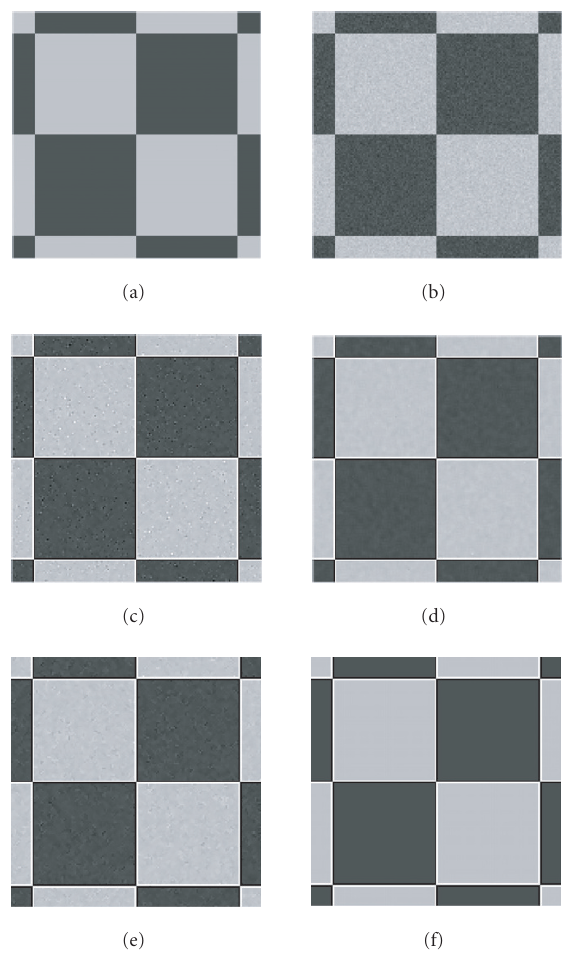
Figure 3: Details of (a) a synthetic image, (b) image corrupted by Gaussian noise with variance 50, (c) enhanced image ( k sm = 10, k sh = 5, no additional processing), (d) enhanced image ( k sm = 20, k sh = 5, no additional processing), (e) enhanced image ( k sm = 15, k sh = 5, postprocessing), and (f) enhanced image ( k sm = 15, k sh = 5,